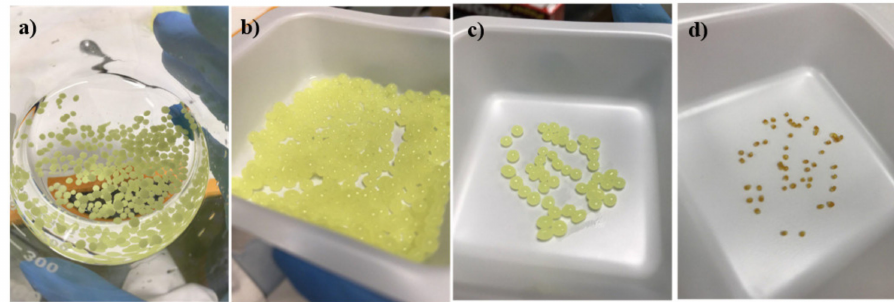
Figure A2. The KCl crosslinking and drying process of CUR-MCT-KC beads. ( a ) 5% KCl was used to crosslink and solidify the CUR-MCT-KC beads, ( b ) the drying process of CUR-MCT-KC beads at room temperature in a light-protected container, ( c ) beads after 1-day of drying, ( d ) dried and solidified CUR-MCT-KC beads. Table A1. The FTIR absorption bands and associated functional groups of individual CUR, MCT, and KC. Descriptions—Characteristics of Different Component Functional